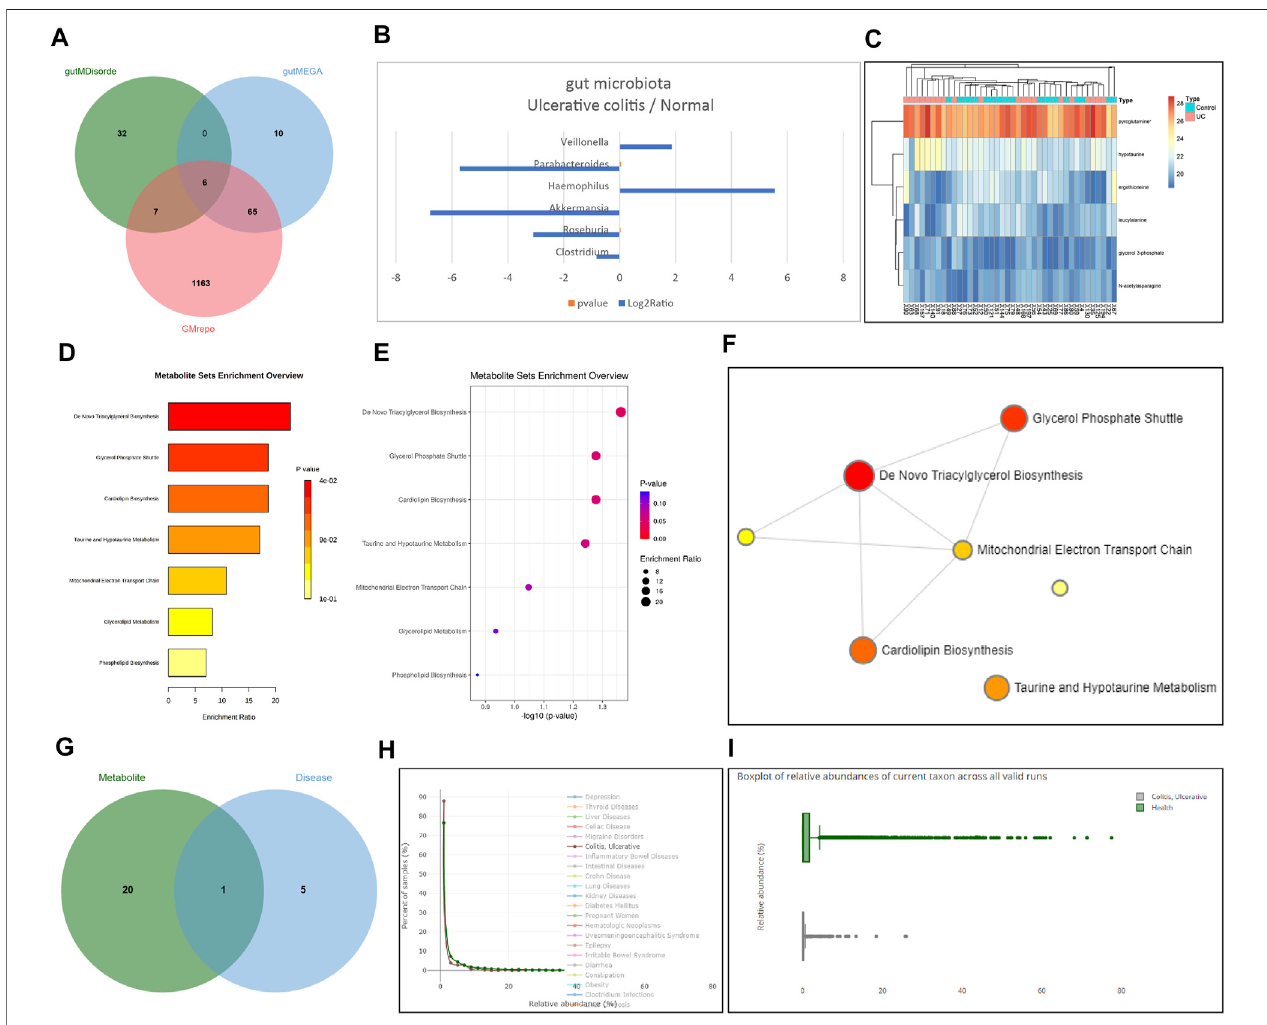
FIGURE5| RSVimprovestheintestinal fl orastructureofUCmicebyinhibitingthePI3K/Aktpathway. (A) TheVenndiagramoftheintersectionofintestinalbacteria associated with UC predicted by the databases GMrepo, gutMEGA, and gutMDisorder. (B) Signi fi cantly different intestinal fl ora in the log2Ratio of UC samples and normal samples. (C) Differential metabolites and the expression heat map of the differential metabolites were drawn. (D) Bar graph of enrichment analysis results of differential metabolites. (E) Dot chart of enrichment analysis results of differential metabolites. (F) Correlation network diagram of metabolites. (G) The presence of differential metabolites of microbes and UC of the differential microorganisms intersects Venn map was predicted using VMH database. (H) Distribution map of relative abundance of Akkermansia in healthy samples and UC samples. (I) Box plot of the relative abundance of Akkermansia in healthy samples and UC samples.